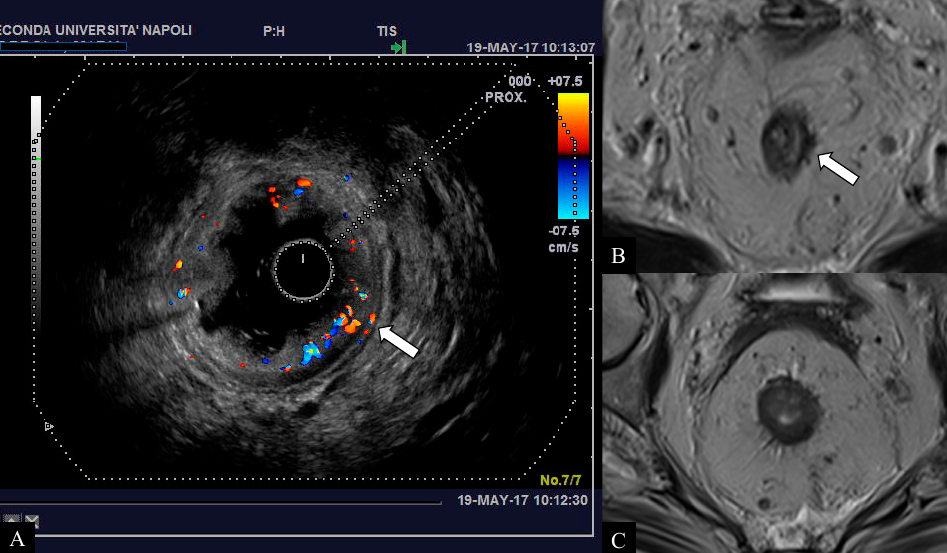
Figure 4. Early-stage tumor affecting the middle rectum in a 64-year-old woman. Endorectal ultra- sound (ERUS) scan ( A ) demonstrates the presence of pathological rectal tissue confined to the left submucosal wall with preserved definition of the hypoechoic layer of muscolaris propria (arrow) referable to an initial clinical stage (T2) of the disease. The axial T2-weighted images ( B , C ) obtained with magnetic resonance imaging (MRI) raised the suspicion of extra-parietal infiltration due to evidence of spiculation in the perivisceral mesorectal tissue (arrow). The histological examination confirmed the desmoplastic nature of the tissue with the presence of granulocytes and eosinophils, suggestive for a reactive/inflammatory tissue.